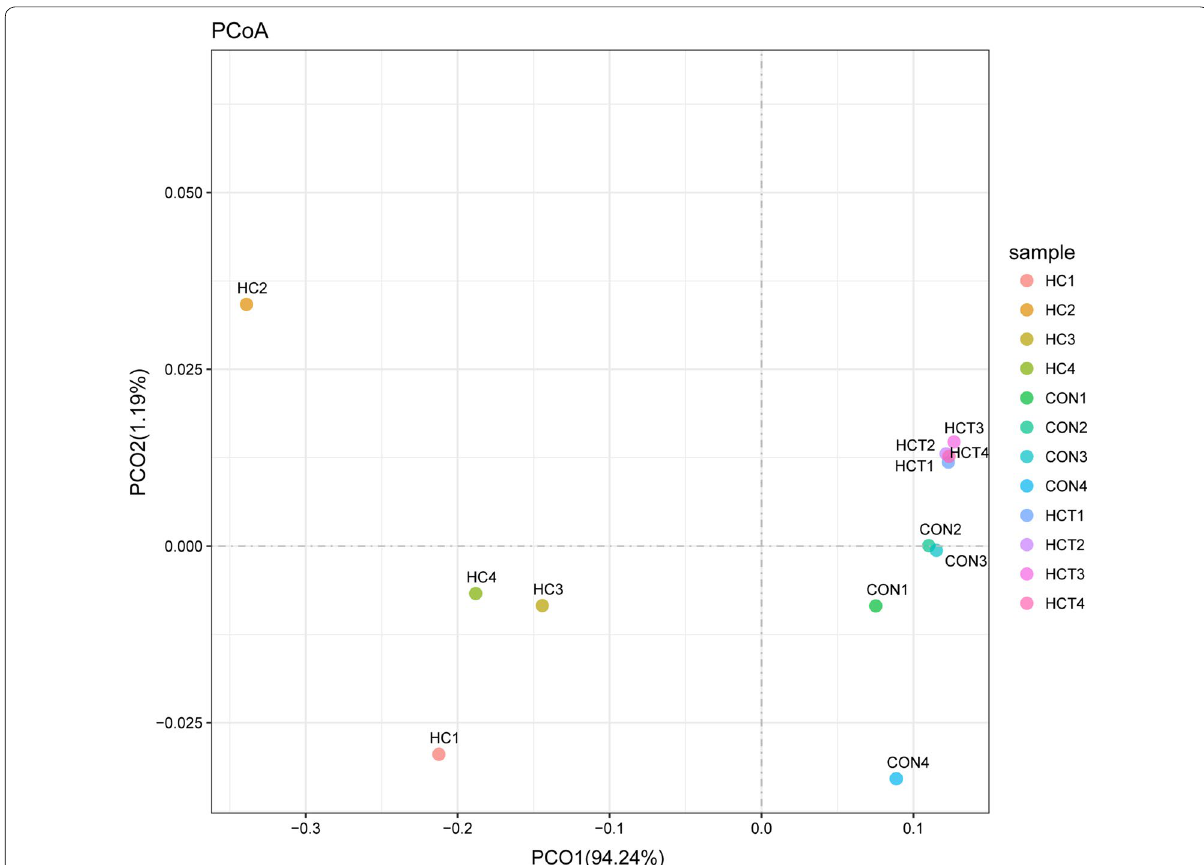
Fig. 1 Principal coordinate analysis (PCoA) of fungi community structures of the ruminal fungi in CON, HC and HCT groups. CON, control diet; HC, high-concentrate diet; HCT, high-concentrate diet supplemented with 180 mg thiamine/kg